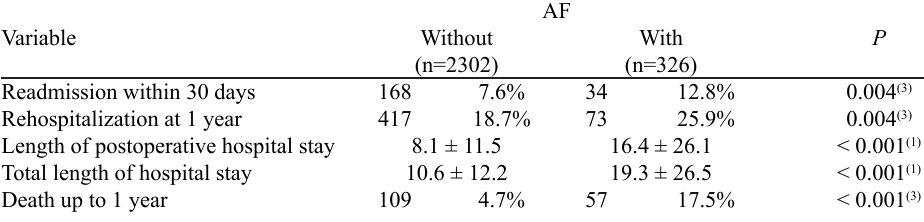
Table 4. Descriptive values for the postoperative period